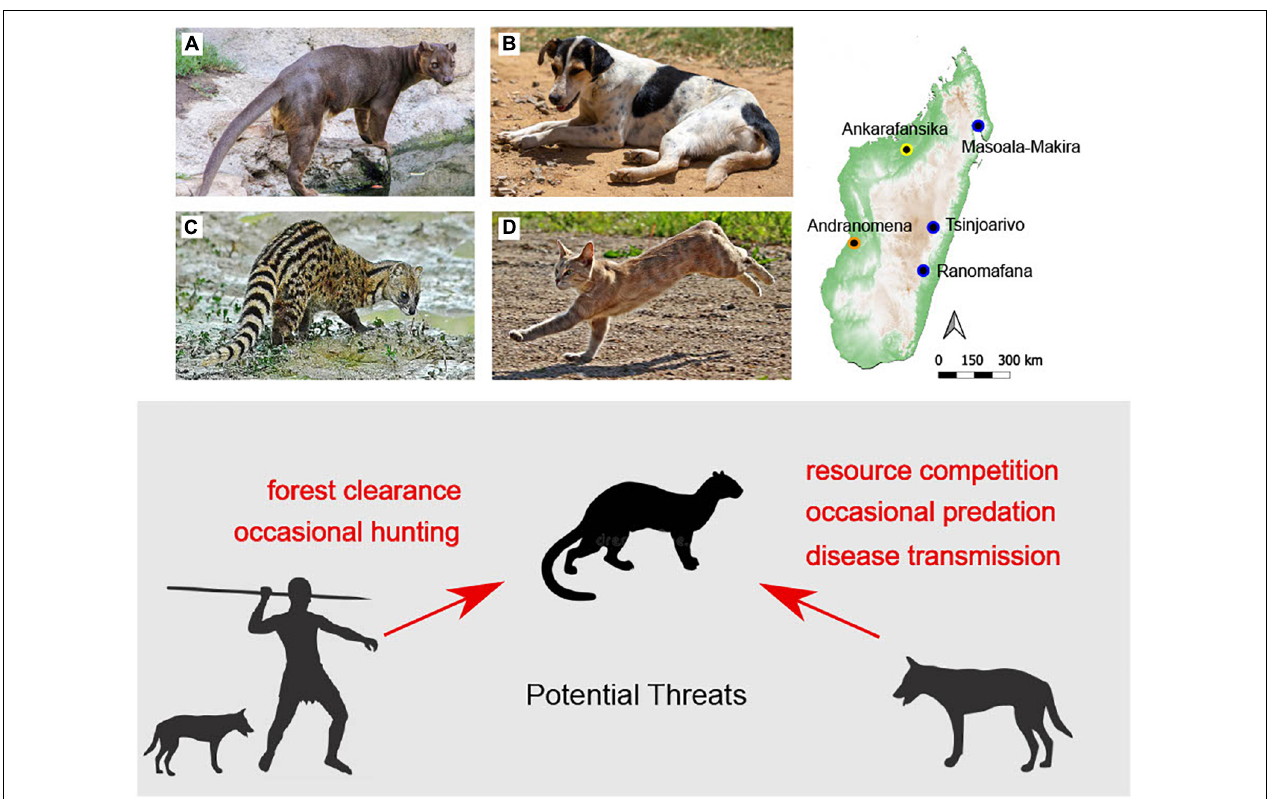
FIGURE 1 | Endemic fosa ( A , Cryptoprocta ferox ) may interact with introduced dogs ( B , Canis familiaris ), Indian civets ( C , Viverricula indica ), and cats ( D , Felis sp.). National parks discussed in the text where antagonistic interactions between introduced and endemic predators have been observed are shown in the map at right. The ecoregion for each park is denoted using colors (orange = succulent woodland, yellow = dry deciduous forest, blue = central highlands and humid forest). Human and introduced predator threats to C. ferox are summarized in shaded area